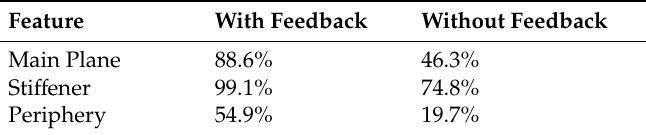
Figure 30. Histogram comparison of feature accuracy. Table 3. Summary table of percentage of feature within ± 50 µ